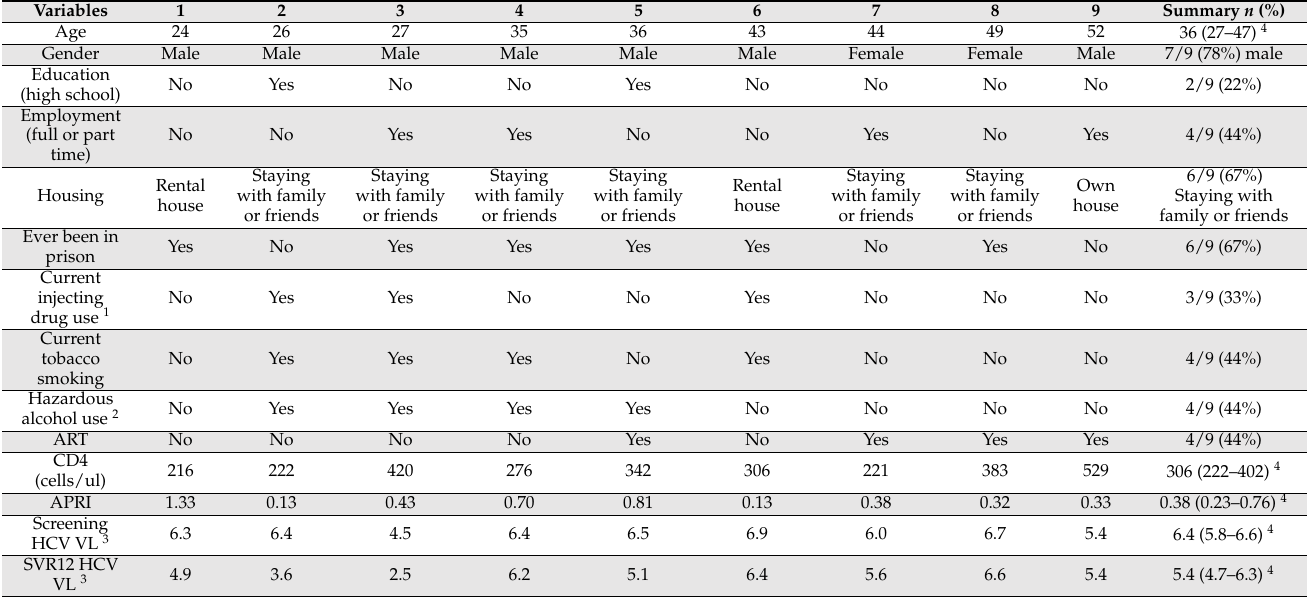
Table 3. Virological failure characteristics by